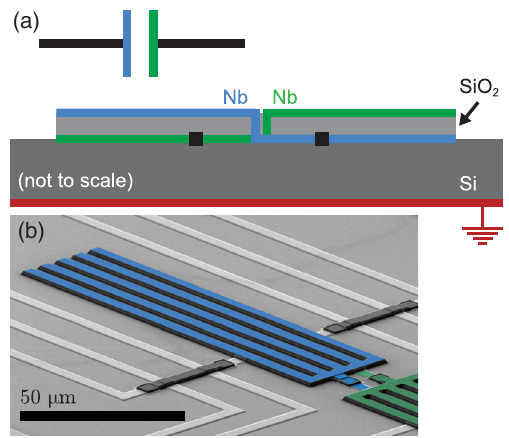
FIG. 10. (a) Schematic illustrating the symmetrization of the parallel-plate capacitors used in the device. To create a capacitor c , two capacitors with half the desired capacitance are connected in parallel, such that the upper (lower) plate of the first capacitor is galvanically connected to the lower (upper) plate of the second. This procedure gives each side of the capacitor the same parasitic capacitance to the ground plane. (b) False-color scanning electron microscope image showing one of the c= 2 capacitors used in the device (blue), and the joint connecting it to another c= 2 capacitor (green), as described in (a). The plates in both capacitors are formed from narrow niobium strips of width w ¼ 5 μ m to prevent trapping flux vortices